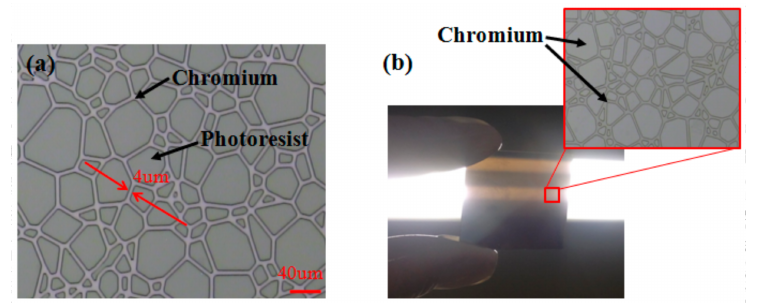
Figure 3. Mask pattern was transfer to ( a ) photoresist layer ( b ) chrome